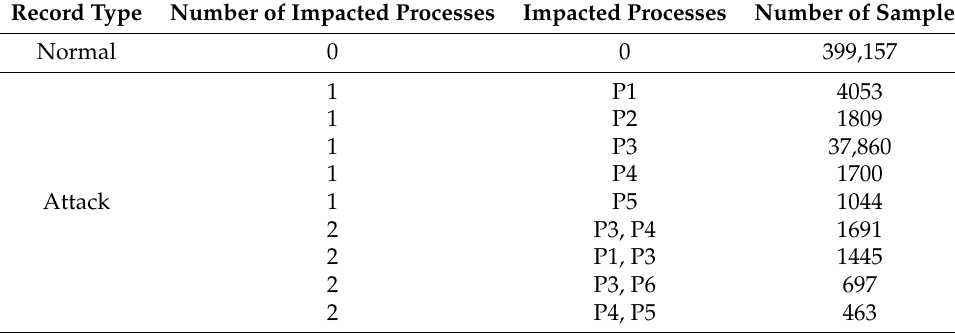
Table 3. Distribution of the attacks per processes in SWaT dataset